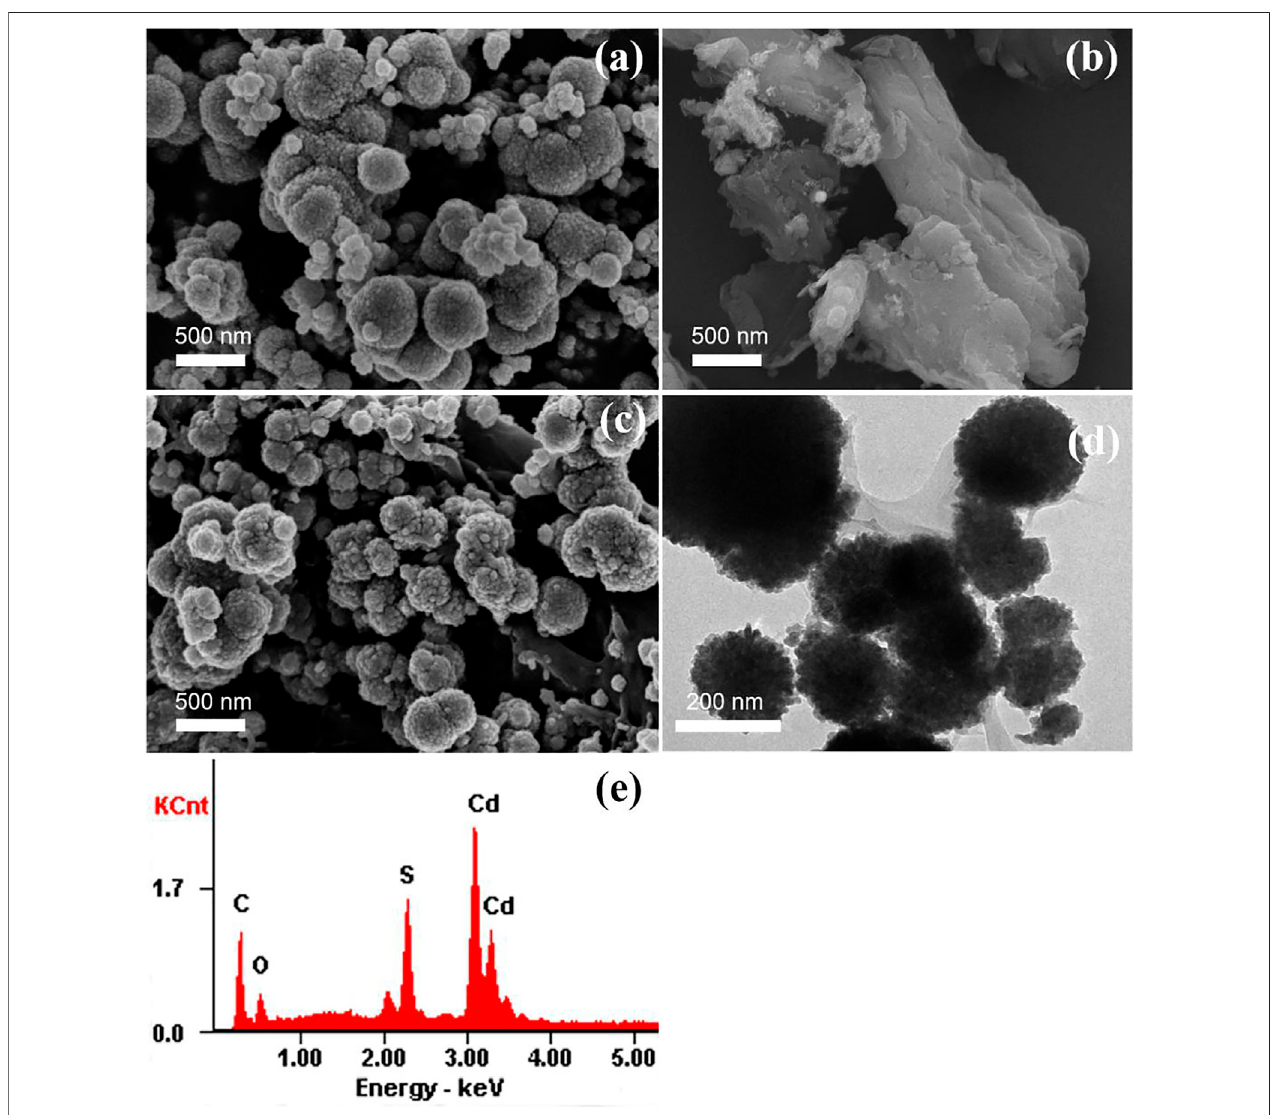
FIGURE 2 | FE-SEM image of (A) CdS and (B) MCC; (C) FE-SEM image, (D) TEM image and (E) EDS pattern of CdS/MCC-10%.